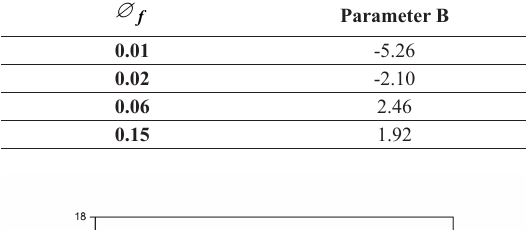
Table 4. Pukánszky model “B” values for the UHMWPE/MQP composites. ∅